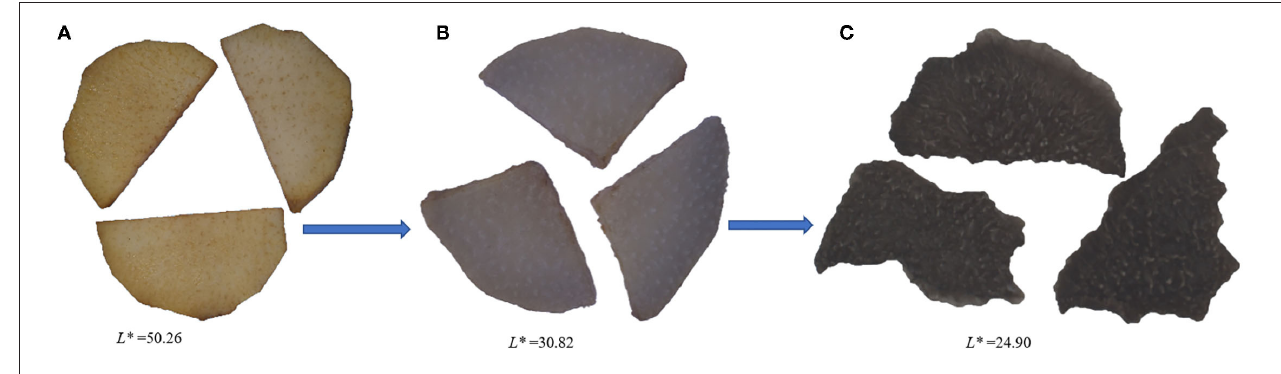
FIGURE 2 | Classification and composition of the 776 metabolites of Cistanche deserticola .